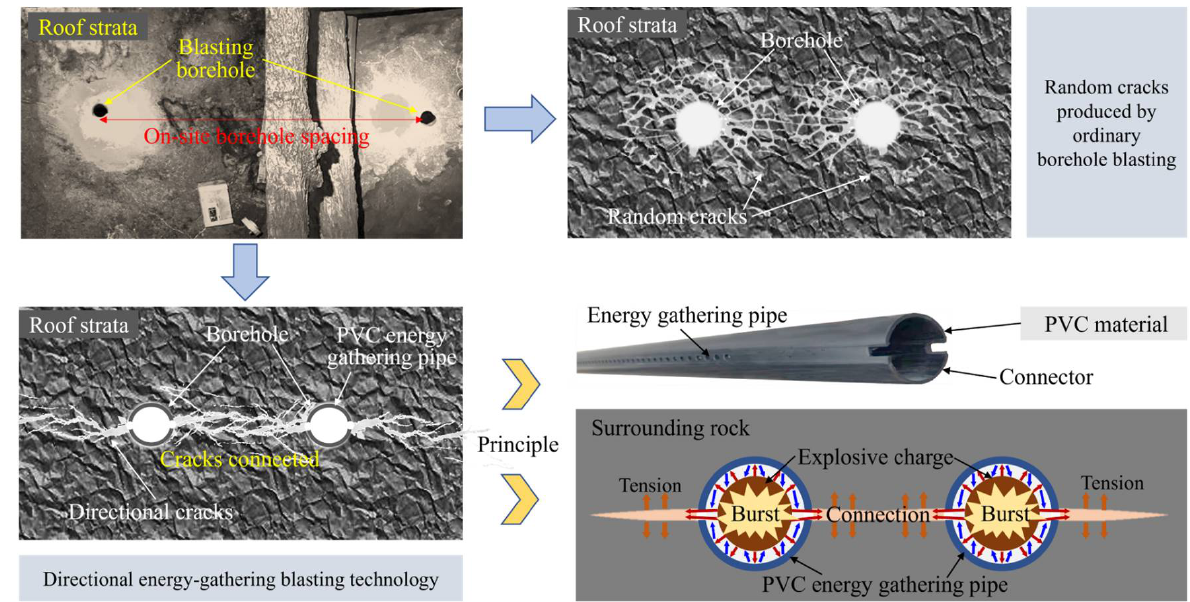
Figure 4. Directional concentrated blasting technology.